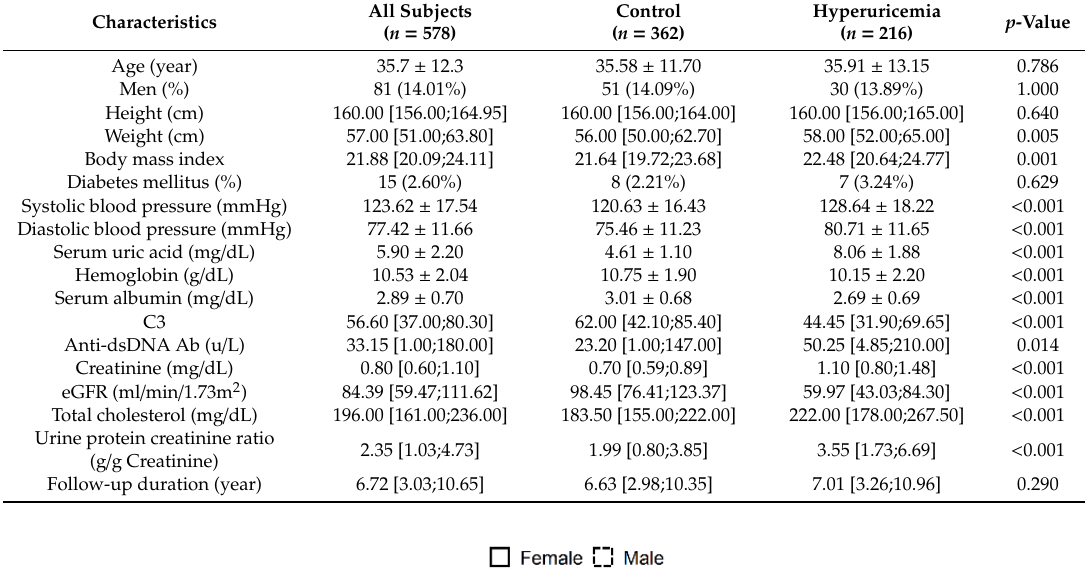
Table 1. Clinical characteristics of the subjects stratified by hyperuricemia. Characteristics